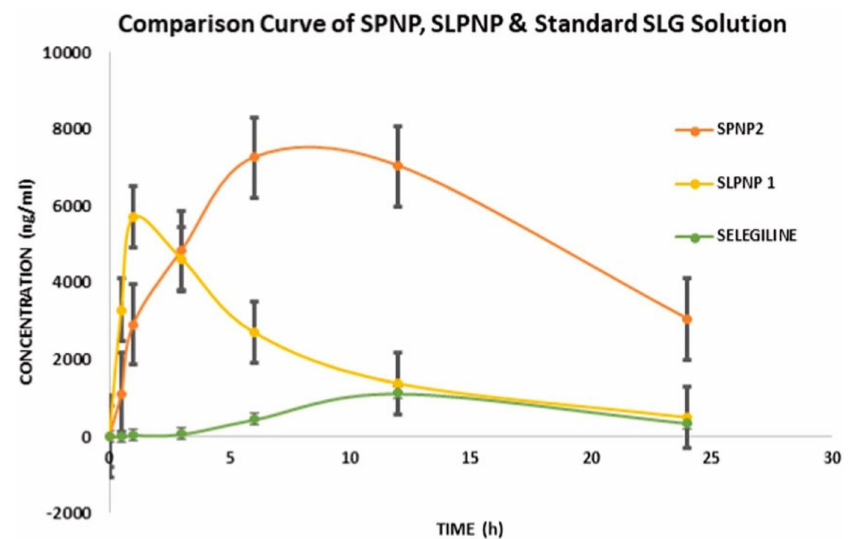
Figure 4. Concentrations of selegiline in rat brain tissue after administration of different dosage forms, SPNP is a selegiline PLGA nanoparticle, SLPNP is a Phospholipon ® 90 G modified selegiline PLGA nanoparticle [51]. Copyright 2022,